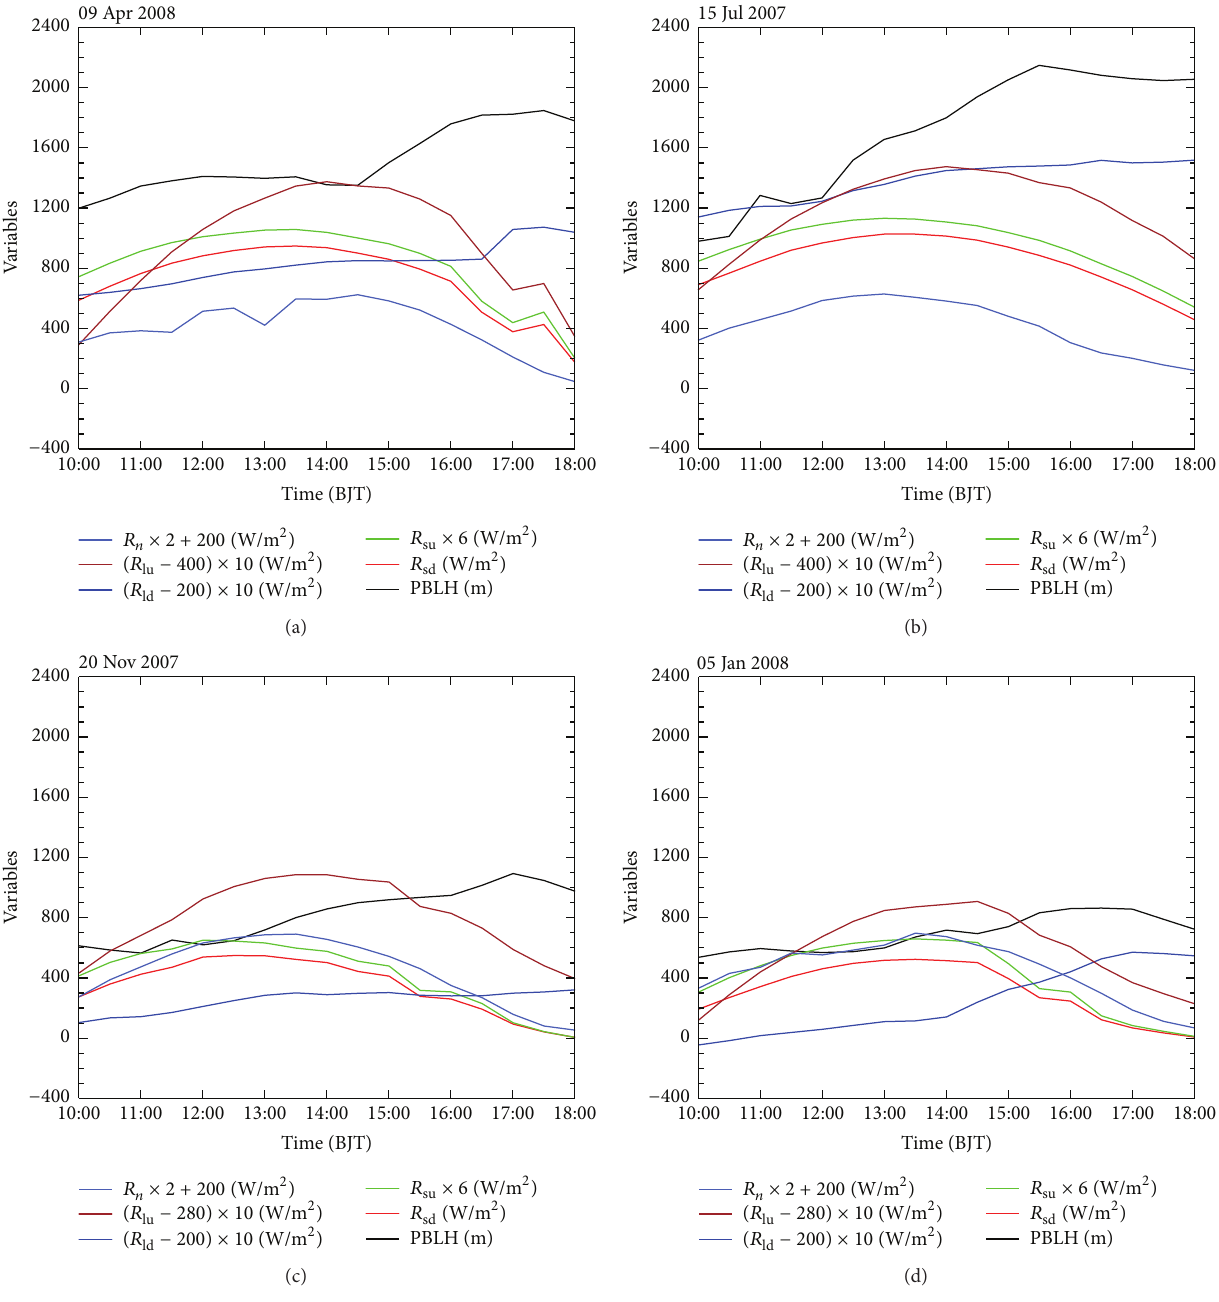
Figure 4: Temporal variations in boundary layer height (PBLH), downward short wave radiation ( 𝑅 sd ), upward short wave radiation ( 𝑅 su ), downward long wave radiation ( 𝑅 ld ), upward long wave radiation ( 𝑅 lu ), and net radiation ( 𝑅 𝑛 ) on (a) 9 April 2008, (b) 15 July 2007, (c) 20 November 2007, and (d) 5 January